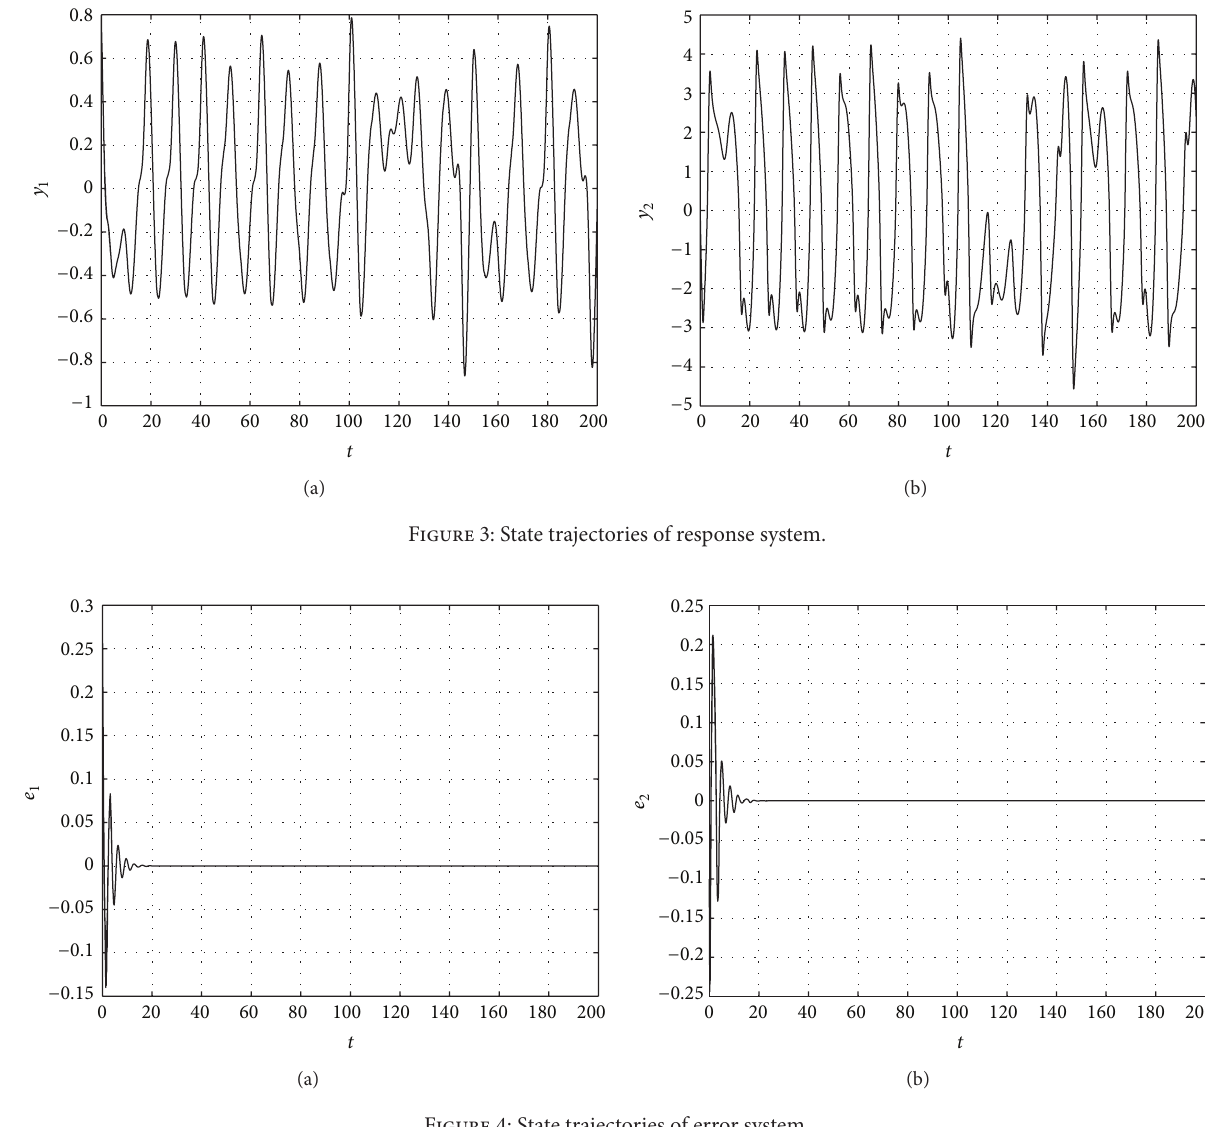
Figure 4: State trajectories of error